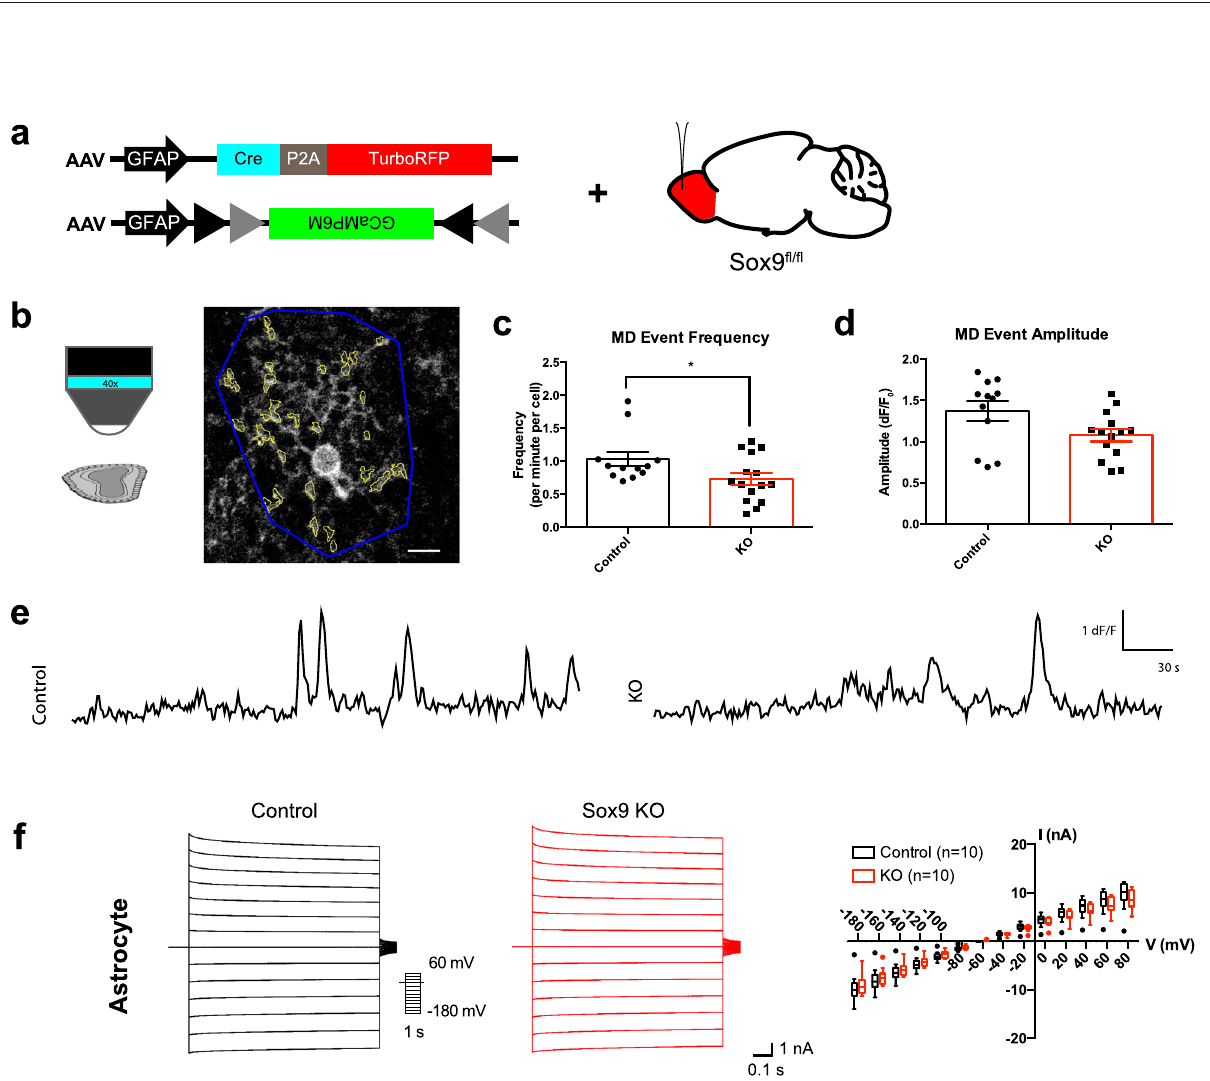
Fig. 1 RNA-seq identi fi ed Sox9 as an important transcription factor in mature, adult astrocytes. a Cellular composition of the OB was visualized using t-distributed stochastic neighbor embedding (t-SNE). Single-cell sequencing allowed unbiased clustering of cell populations in the OB, revealing 36 distinct populations. Astrocyte clusters are highlighted for identi fi cation. b Of the 36 populations, 4 astrocyte populations were found based on expression of known astrocyte markers (Aldh1L1 and GFAP). Violin plots show common astrocyte markers along with 4 transcription factors found to be highly expressed across astrocyte populations. c Representative images from coronal sections from the Aldh1L1-EGFP BAC transgenic mouse line showed that immunohistochemical staining of Sox9 colocalizes with astrocytes in the OB. N = 3 mice. Scale bar, 50 µ m. d Representative images from coronal sections from the OB showing Sox9 expression in control animals (left) and tamoxifen-induced KO of Sox9 (right). N = 3 mice. Scale bar, 50 µ m. e – g High-resolution imaging and surface rendering of astrocytes in OB shows a decrease in morphological branching in Sox9 KO vs controls. n = 33 cells (control) and n = 40 cells ( Sox9 KO) from N = 3 mice, respectively. Adjusted p = 0.0021, 0.0046, 0.0219, and 0.0230 for total process length, # primary fi lament, # branch points, and # terminal points, respectively; 2-way ANOVA with Sidak ’ s multiple comparison correction. Data are presented as box plots displaying interquartile range and median with Tukey whiskers. Scale bar, 20 µ m. h – j High-resolution imaging and surface rendering of astrocytes in cortex shows no signi fi cant change in morphological branching in Sox9 KO vs controls. n = 39 cells (control) and n = 35 cells ( Sox9 KO) from N = 3 mice, respectively. 2-way ANOVA with Sidak ’ s multiple comparison correction. Control in E-J is Sox9 fl / fl ; Aldh1L1-EGFP. Data are presented as box plots displaying interquartile range and median with Tukey whiskers. Scale bar, 20 µ m.